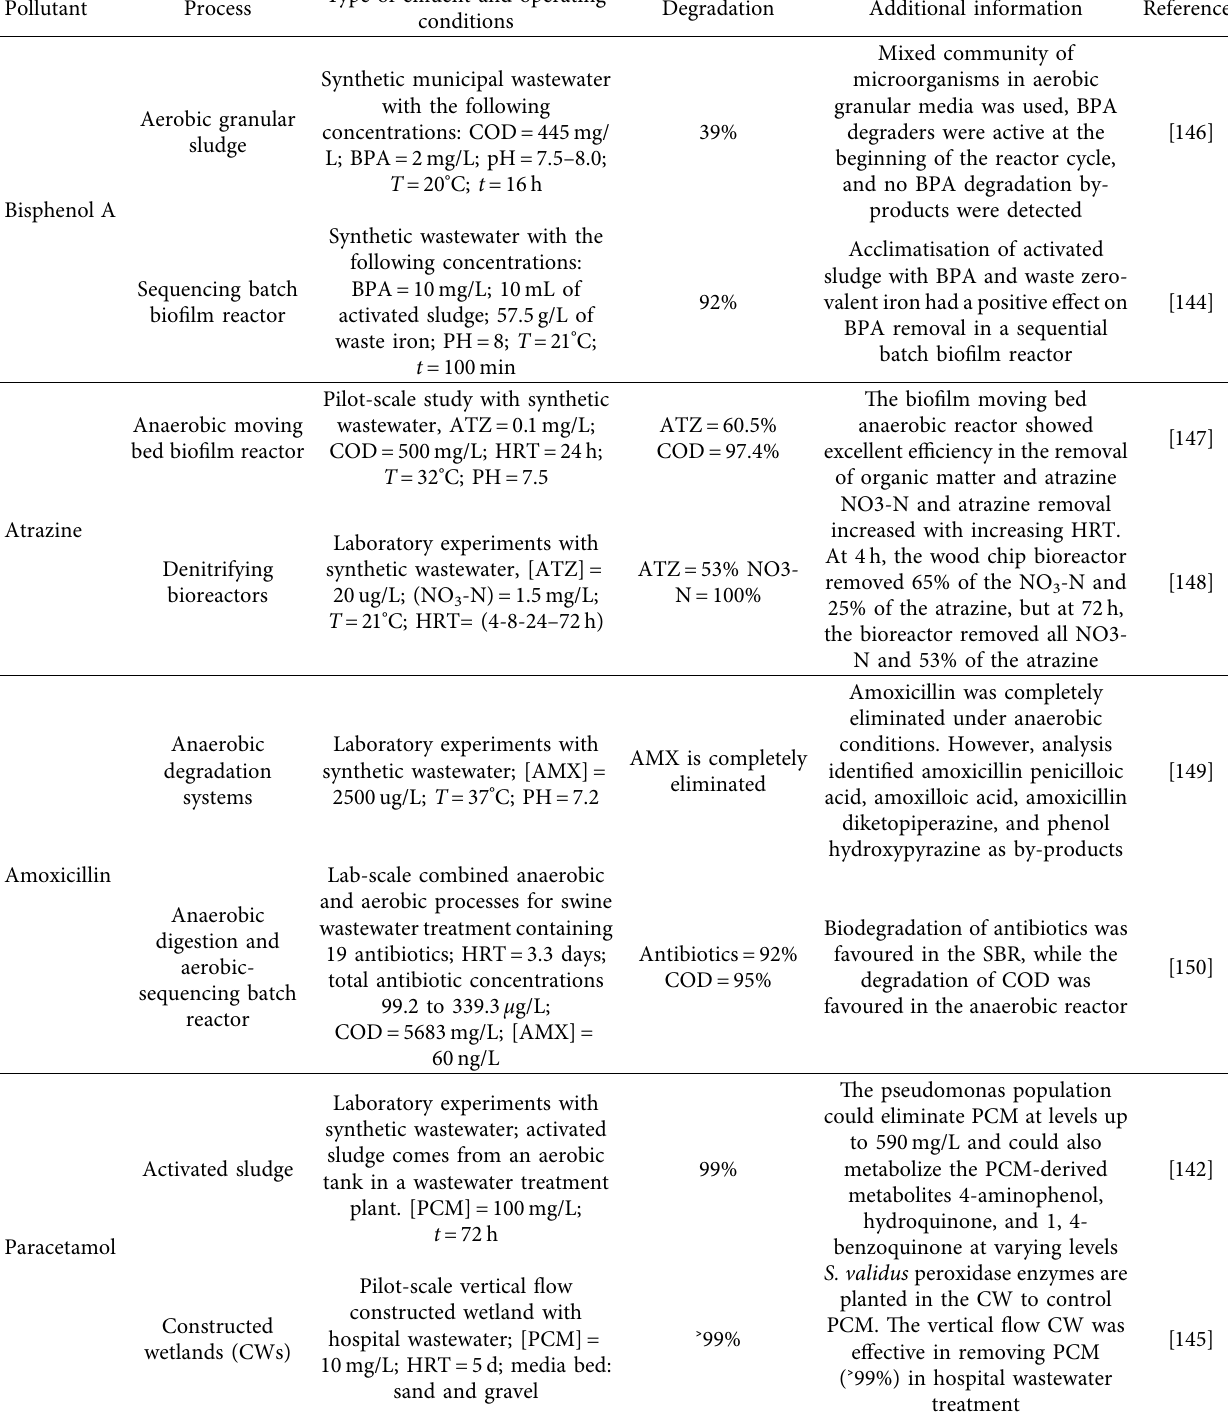
Table 5: Biological processes used for the degradation of emerging